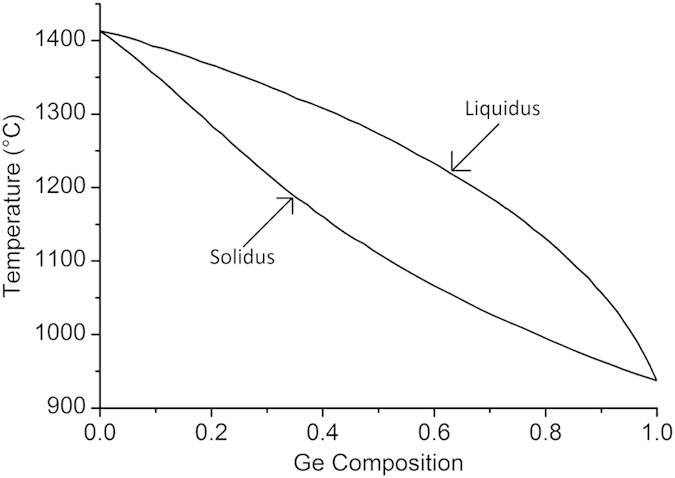
SiGe phase diagram – adapted from29.